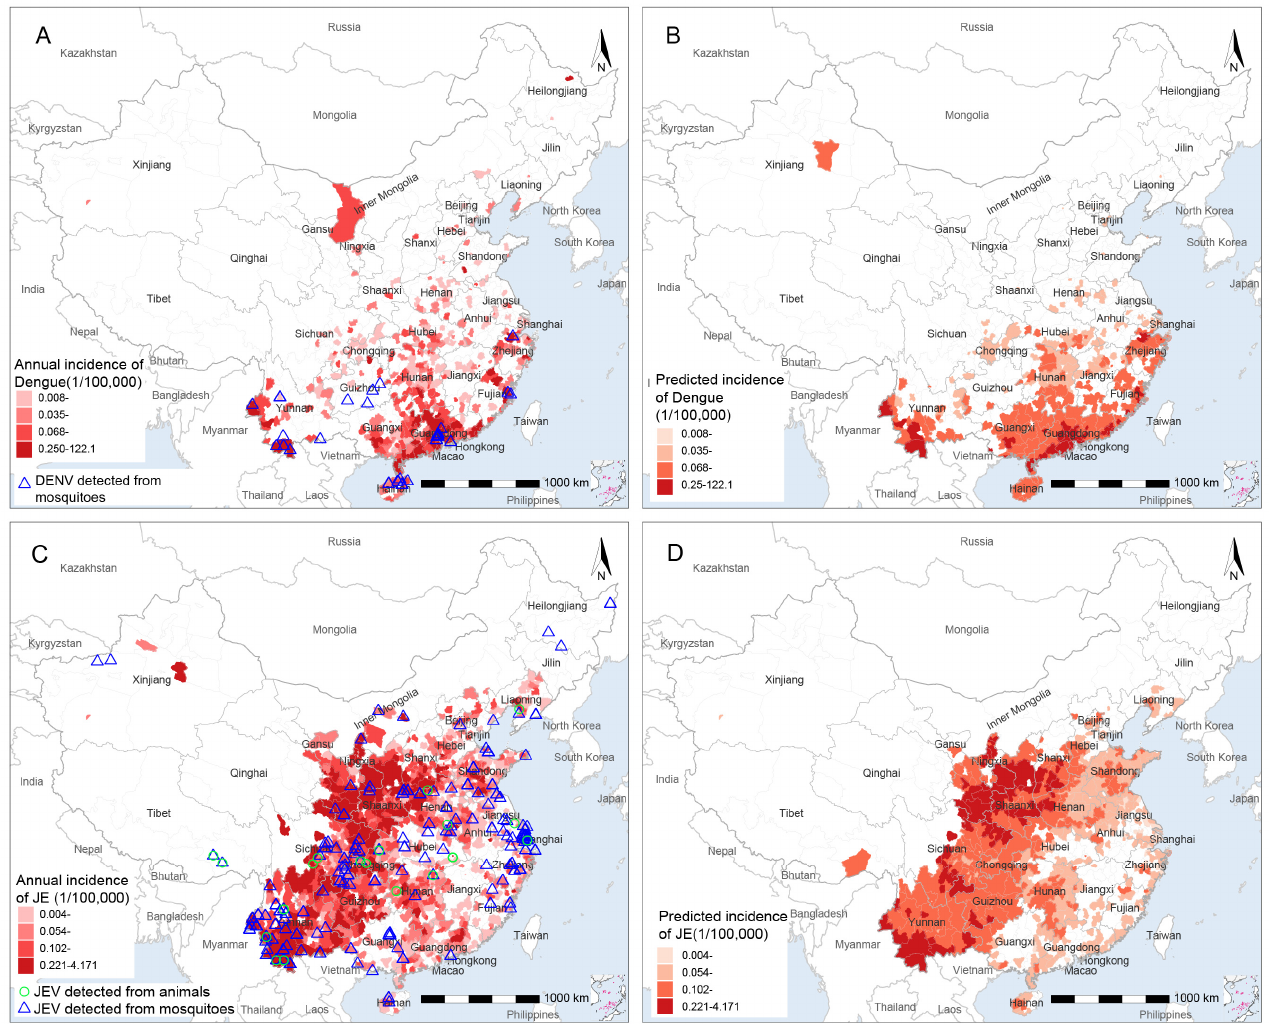
Figure 4. The reported and model-predicted distributions of dengue and JE at the county level in China. ( A ) Reported annual incidence rate of human dengue and locations of DENV detected from mosquitoes; ( B ) spatial distribution of model-predicted incidence rate of dengue; ( C ) reported annual incidence rate of human JE and locations of JEV detected from mosquitoes and host animals; ( D ) spatial distribution of model-predicted incidence rate of JE. Table 2. Mean (standard deviation) relative contributions of major factors to the spatial distributions of dengue and JE, estimated by two-stage GBRT models.